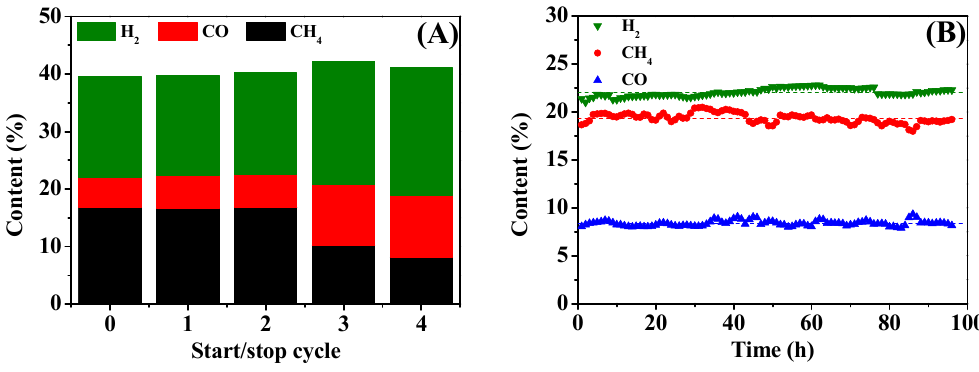
Figure 12. Start/stop cycle test ( A ) and lifetime test ( B ) of 15Ni-3Mn catalyst at 350 ◦ C, H 2 /CO = 0.8 and H 2 O/CO = 1.